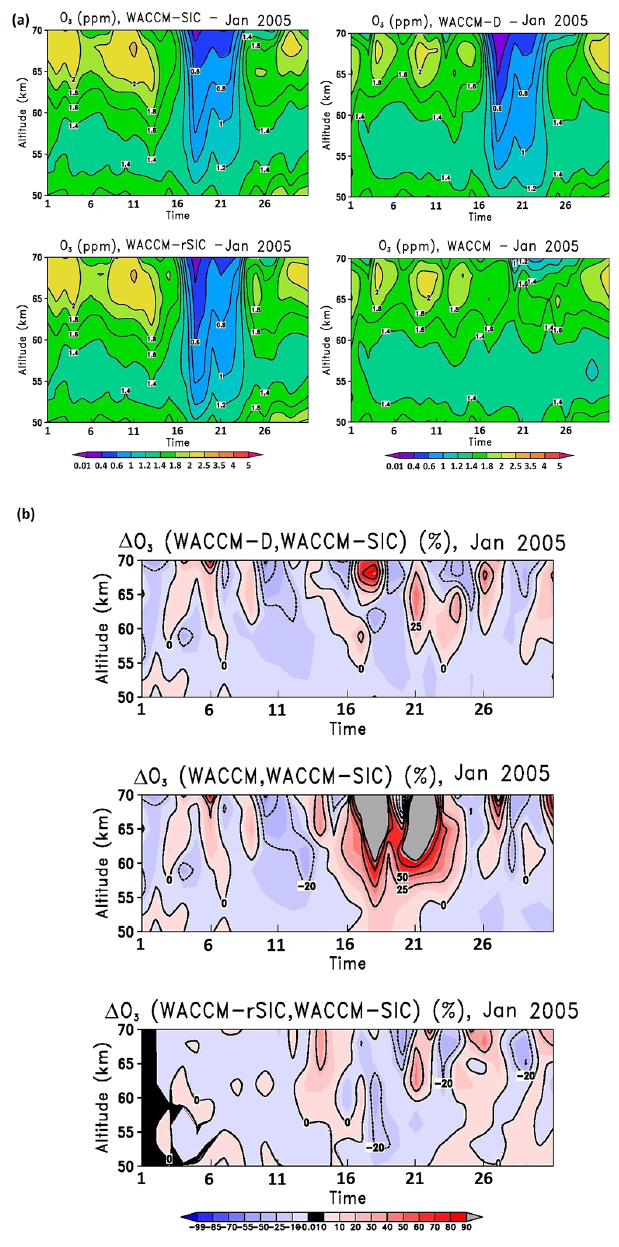
Figure 3. (a) Zonal mean vertical concentration profiles of meso- spheric O 3 (in ppm) for Northern Hemisphere polar latitudes (60– 90 ◦ N) during January 2005; (b) percentage difference between three models (WACCM-D, WACCM and WACCM-rSIC) and the full